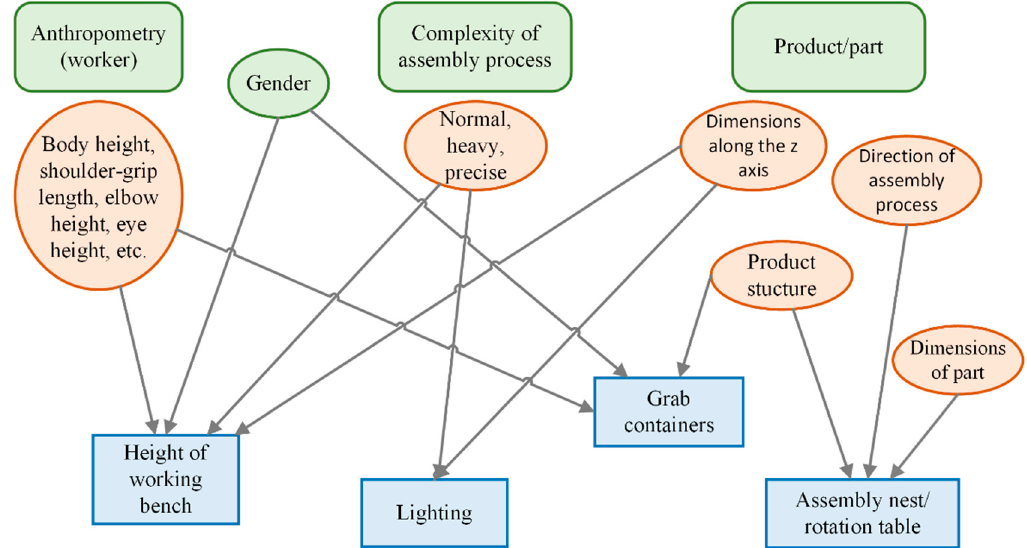
Figure 3. Dependence between the influential parameters of the smart algorithm and their impact on the control of the smart manual assembly workstation.